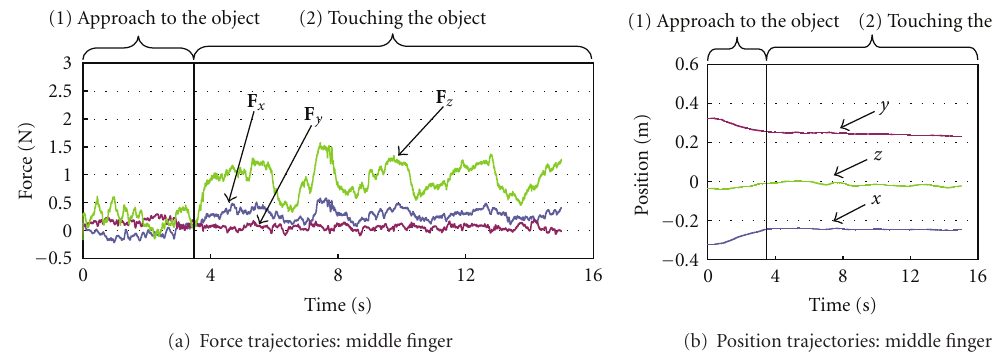
Figure 16: The force and position trajectory of the trainer.